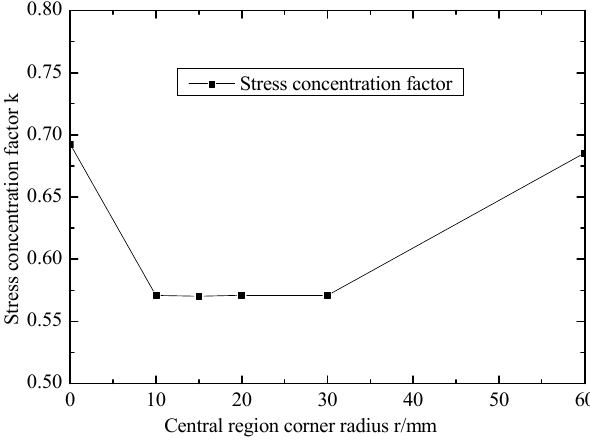
Figure 6. Effect of central region corner radius on stress in central region. Figure 6. E